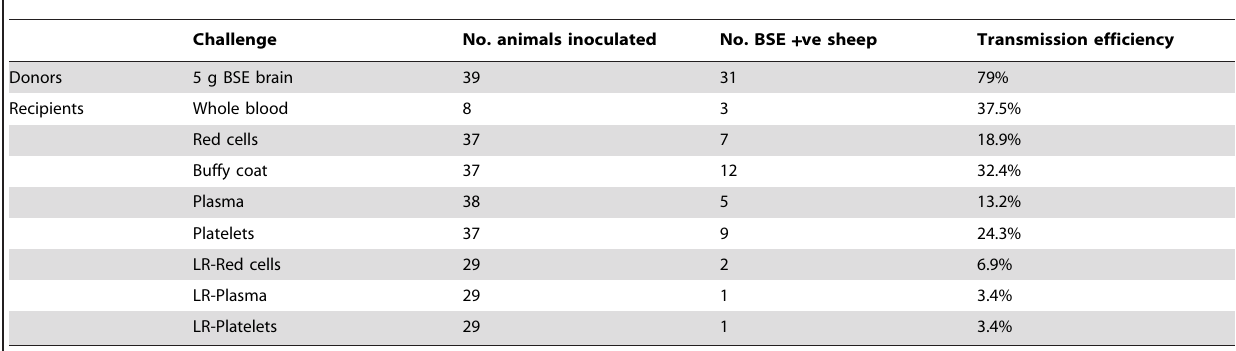
Table 2 identifies the number of positive transmissions of BSE, by the component transfused to recipients. The current transmission efficiency of each type of blood component was determined by calculating the number of recipients confirmed as having BSE (post-mortem) as a percentage of the total number of each component transfused. The attack rate for orally infected BSE donor sheep is shown for comparison. Blood components prefixed by ‘LR’ mean that they were leucoreduced prior to